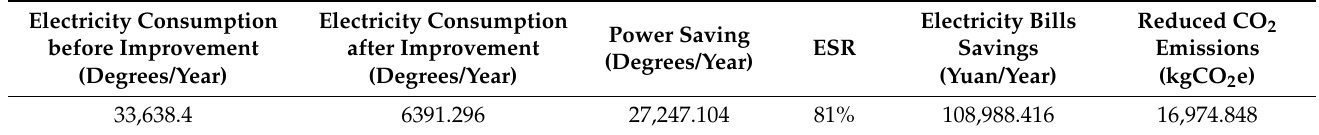
Table 8. Reduced electricity consumption, cost, and carbon emissions of a parking lot during the same